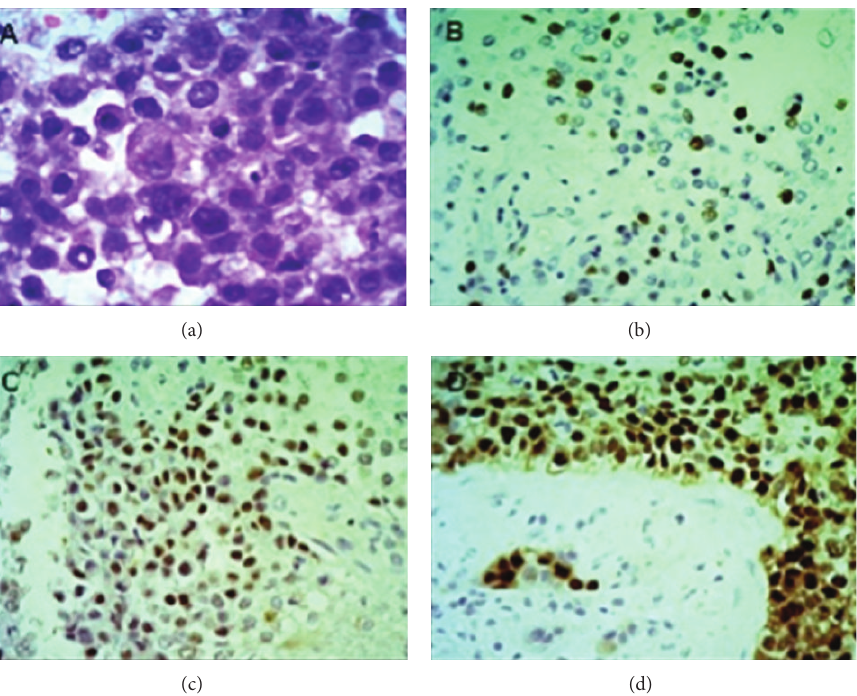
Figure 2: (a) Ductal carcinoma seen on hematoxylin and eosin stain with a solid pattern and a mild nuclear pleomorphism (200x). (b) Immunohistochemical stain with Ki-67 expression in 40% of the cells. (c) Immunohistochemical staining of estrogen receptor expression. (d) Immunohistochemical staining of progesterone receptor